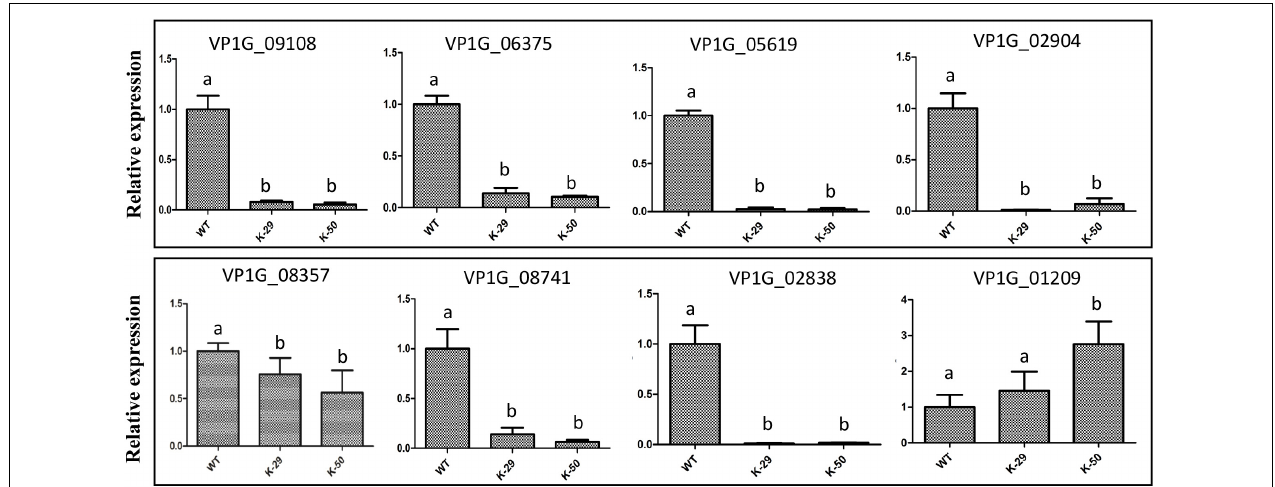
FIGURE 8 | qRT-PCR analysis of the representative DEGs. Expression levels of isotrichodermin C-15 hydroxylase (VP1G_08741), MFS transporter (VP1G_06375), trichodiene oxygenase (VP1G_05619), NPP1 (VP1G_02838), pisatin demethylase (VP1G_08357), fumitremorgin c monooxygenase (VP1G_09108), catalase-related peroxidase (VP1G_01209), and TOX (VP1G_02904). The expression level of each gene was analyzed by qRT-PCR and normalized to actin expression, and the relative expression ratio was calculated as 2 − (cid:49)(cid:49) Ct compared to that of WT. Different letters indicate significant differences, P < 0.05, ANOVA).